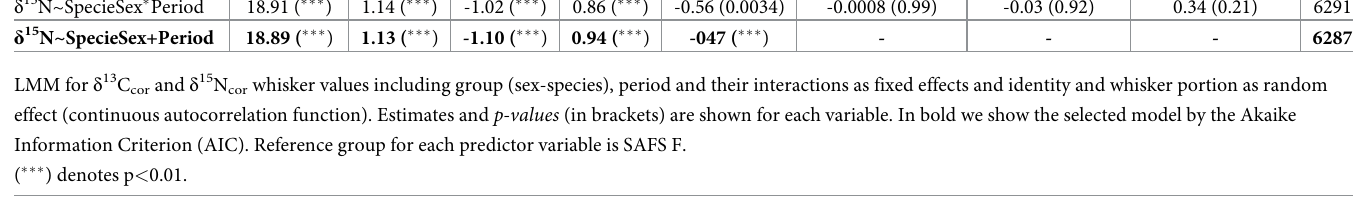
effect (continuous autocorrelation function). Estimates and p-values (in brackets) are shown for each variable. In bold we show the selected model by the Akaike Information Criterion (AIC). Reference group for each predictor variable is SAFS F.